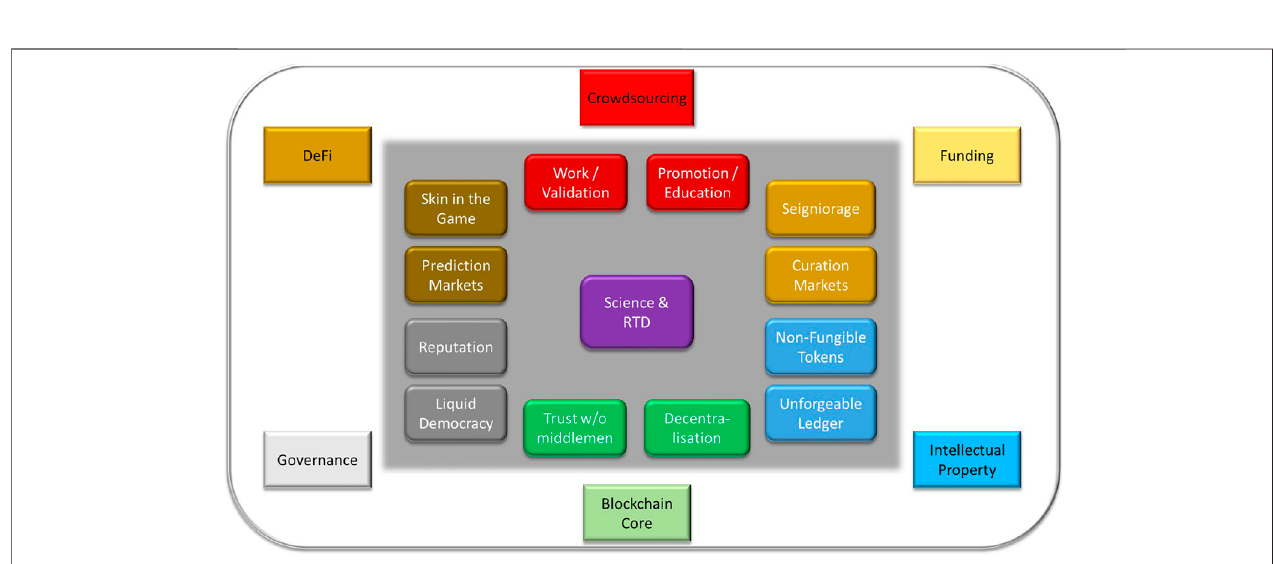
FIGURE 4 | Innovation potential for science and RTD projects through crypto-economically incentivized involvement of collective intelligence. Core blockchain technologies provide trust and trust- fi nding mechanisms without requiring a central authority. Smart contracts enable skin-in-the-game staked prediction markets, novel, liquid democracy style governance schemes involving formalized reputation, a tamper-proof and time-stamped ledger to register intellectual property (IP) which may be represented and traded as non-fungible token (NFT). In addition to conventional mechanisms, project funding can arise from seigniorage and curation markets.Theblockchain-backedtokenizationcanthuseffectivelycrowdsourceprojectcontributions,forexample,work,validation,promotionandeducation, collective intelligence through remuneration, and reputation tokens to thus optimize the project outcomes while acknowledging contributions from individual stakeholders.